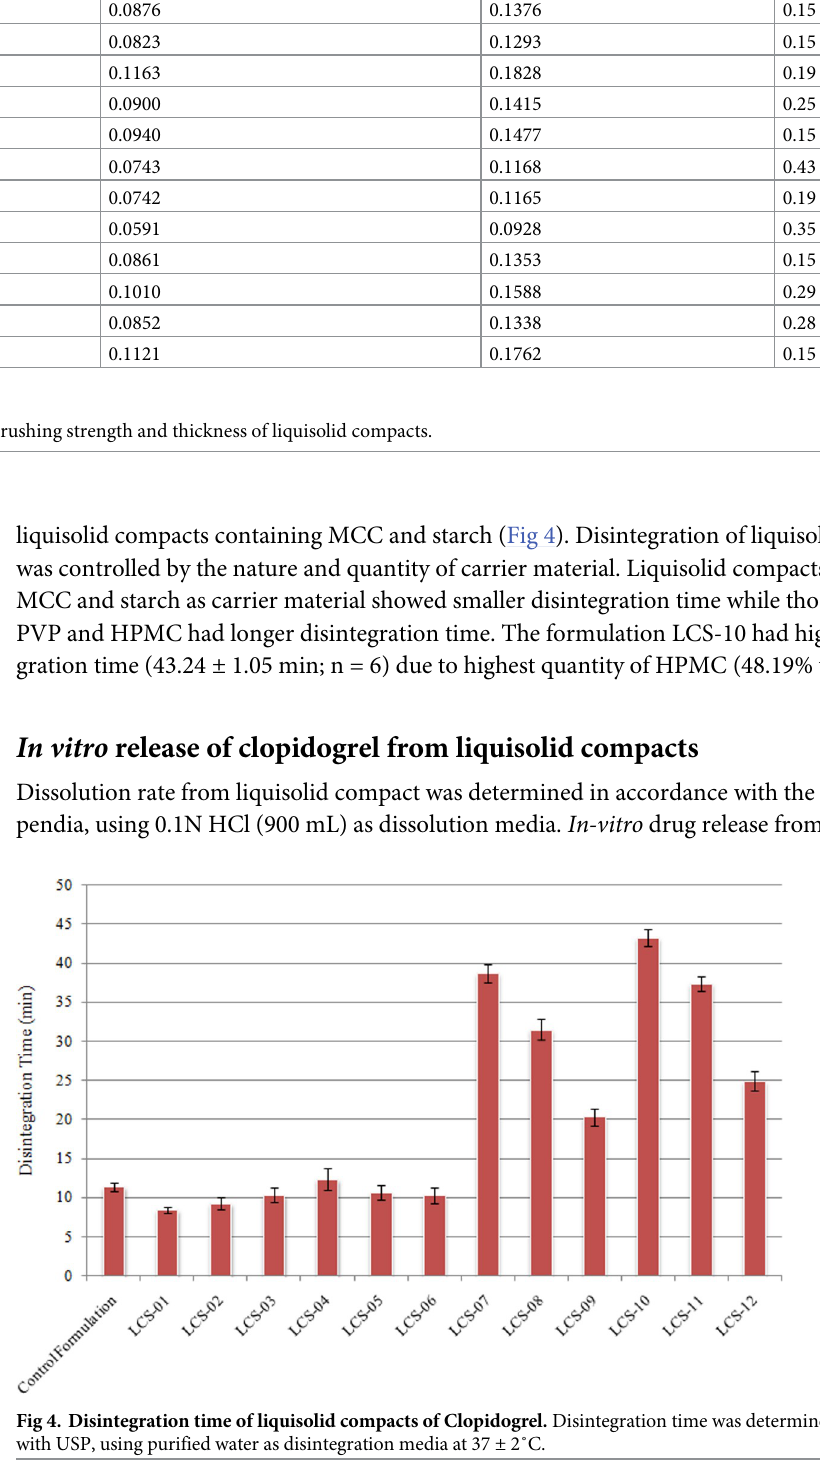
Fig 4. Disintegration time of liquisolid compacts of Clopidogrel. Disintegration time was determined in accordance with USP, using purified water as disintegration media at 37 ±